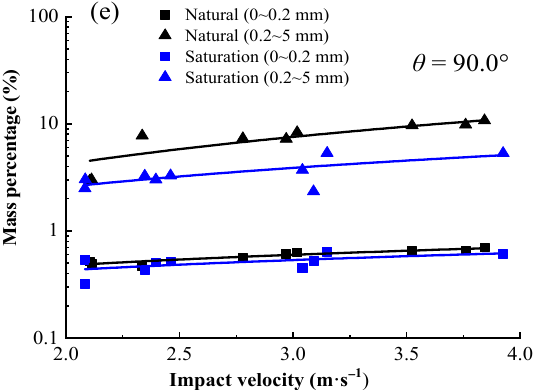
Figure 20. Statistical mass percentage of particle size of broken coal specimens. ( a ) 0°, ( b ) 22.5°, ( c ) 45°, ( d ) 67.5°, ( e ) 90°.